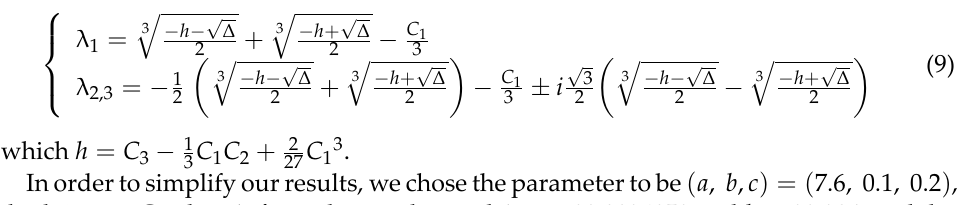
Table 1. The roots of the proposed system obtained via Cardano’s formula. Iteration